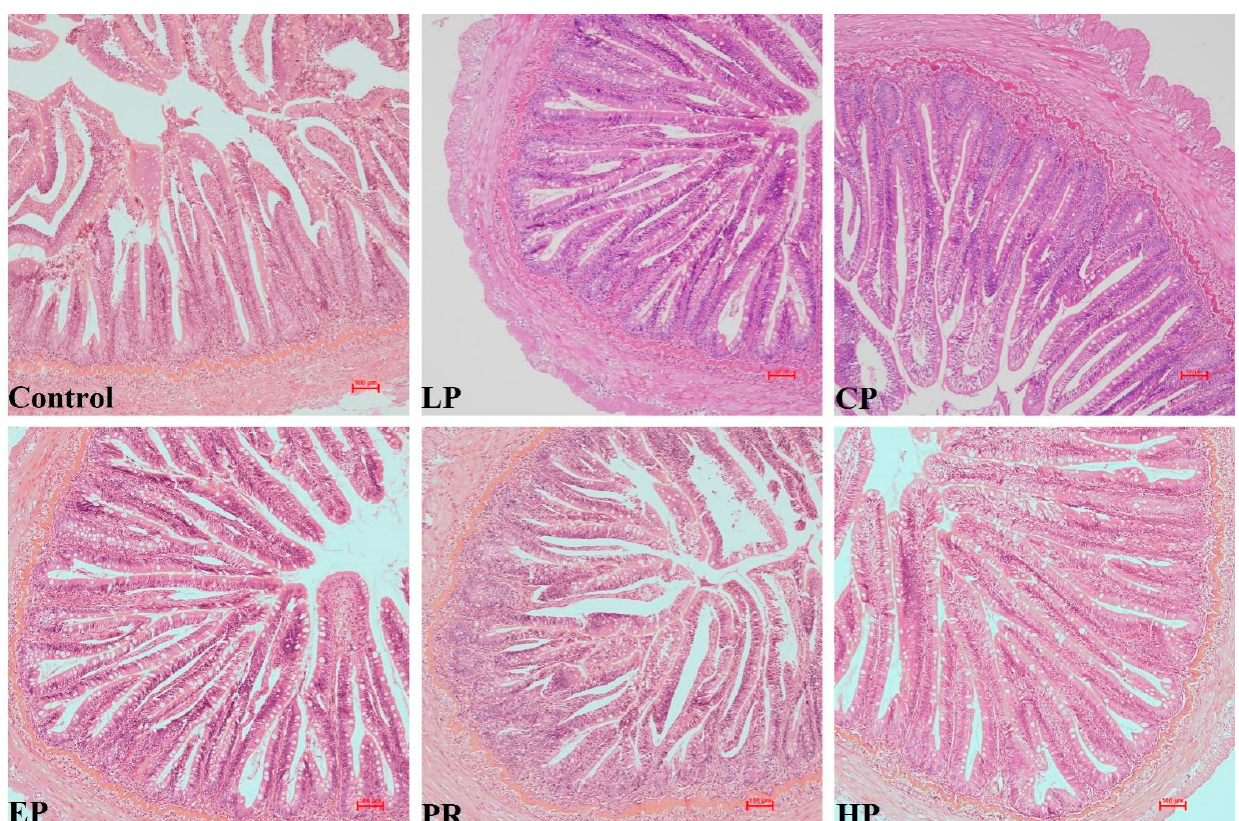
Figure 3. The intestinal histology of Oncorhynchus mykiss was fed with experimental diets for 56 days. Magnification 200×.